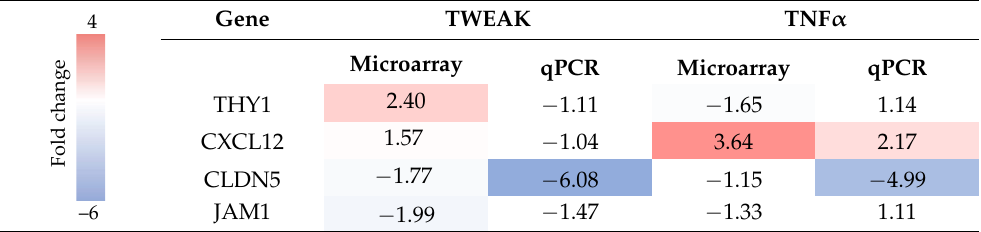
Table 2. Comparison of FCs of DEGs belonging to leukocyte extravasation signaling obtained via microarray and qPCR assays performed on hCMEC/D3 cells after 24 h incubation in TWEAK or TNF α . Upregulated genes (FC > 1.5) are in red and downregulated genes (FC < − 1.5) are in blue.